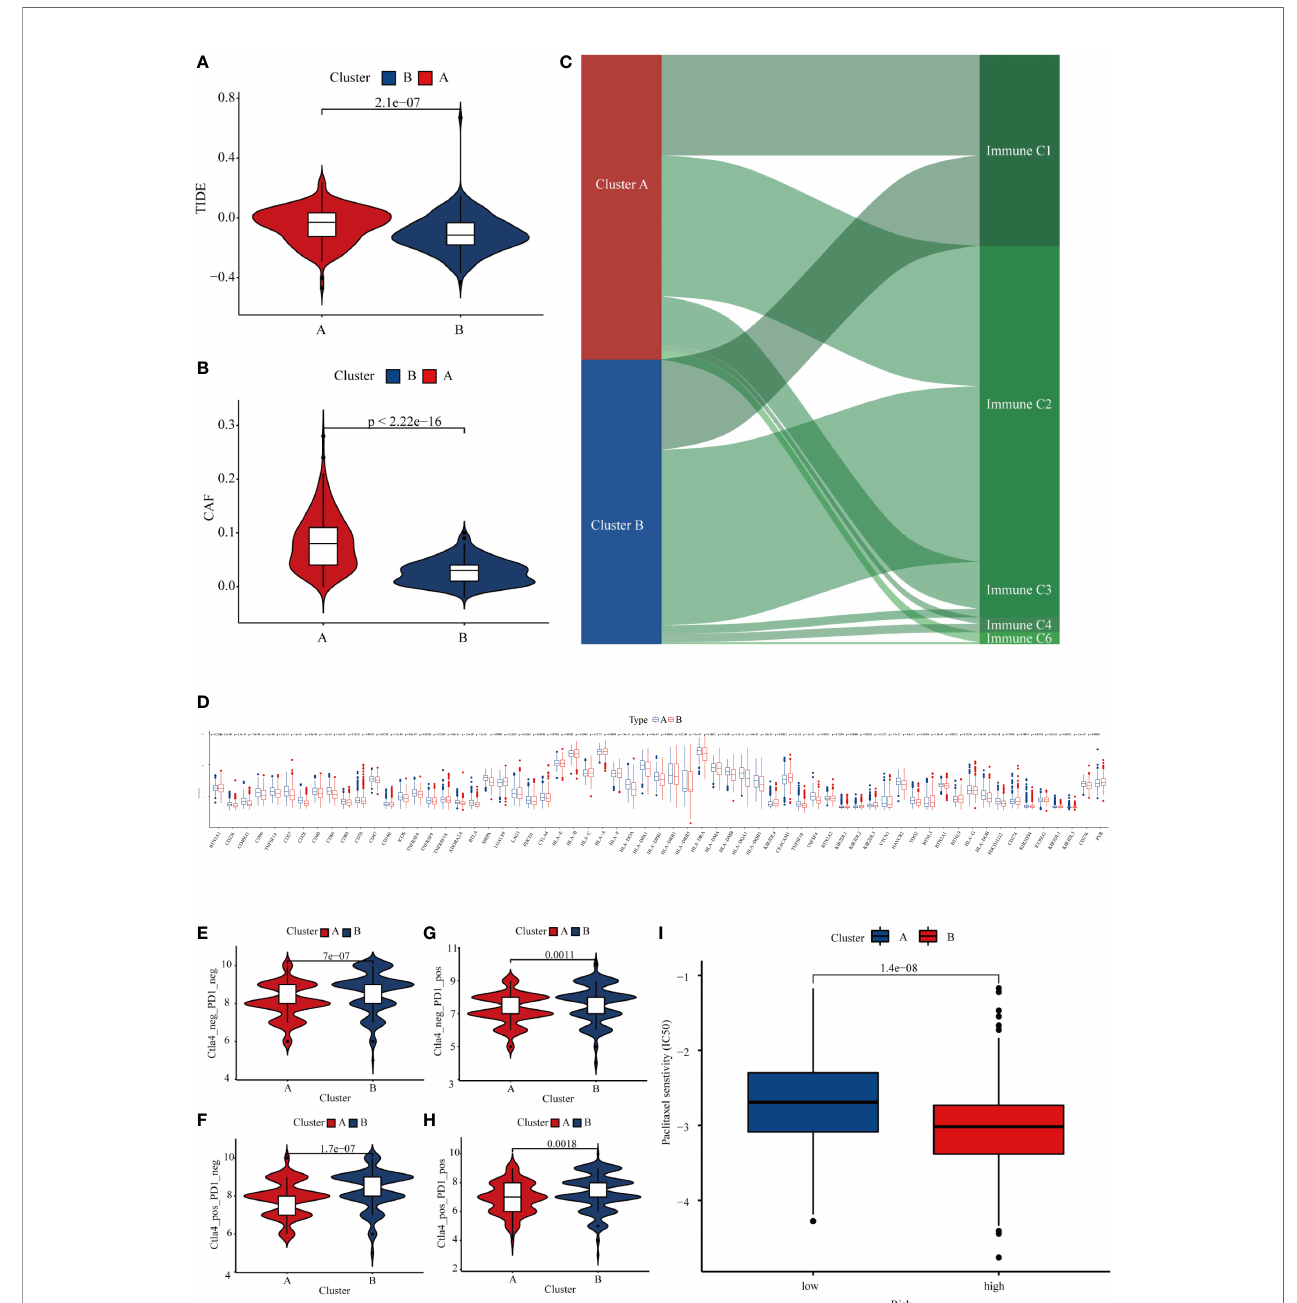
FIGURE 7 | Differences in the responsiveness of patients to chemotherapy, targeted therapy, and immunotherapy in different GC subtypes. (A) The TIDE score in different GC subtypes. (B) Expression of CAF in different GC subtypes. (C) The relationship between GC subtypes and immune expression signatures. (D) Expression of immune checkpoints in different GC subtypes. (E – H) Differences in the responsiveness of GC patients to immune checkpoint inhibitor therapy in different subtypes. (I) The sensitivity of paclitaxel in different GC